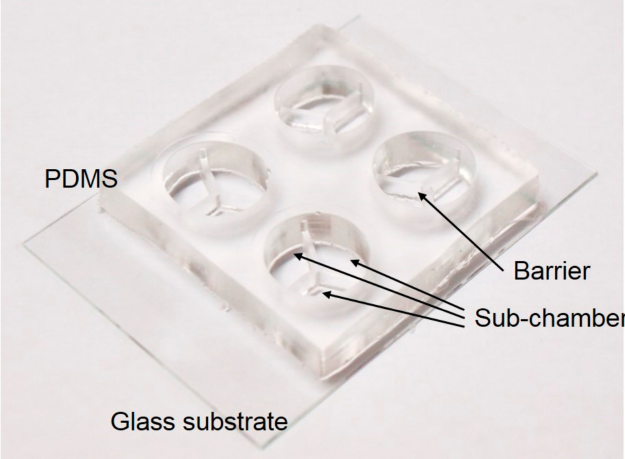
Figure 3. Photograph of the 3-chamber co-culture